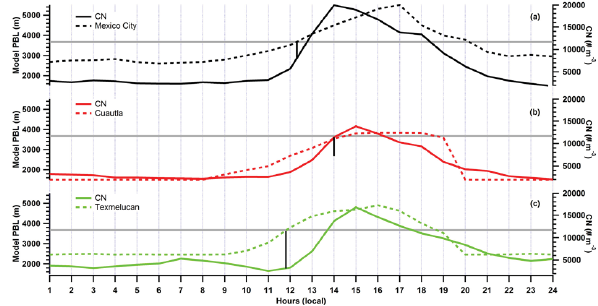
Figure 2. Hourly averages of the simulated boundary layer depths (a.s.l.) and observed CN concentrations are shown here for time periods when air originates from (a) the Fig. 2. Hourly averages of the simulated boundary layer depth WNW, (b) SW and (c) E. The grey line is a reference for the Altzomoni altitude in the model and the vertical black lines in each panel show the times when the (a.s.l.), drawn as dashed lines and observed CN concentration (solid simulated regional boundary layer reaches the altitude of Altzomoni. lines) are shown here for time periods when air originates from (a) the west northwest (Mexico City), (b) southwest (Cuautla) and (c) east (Texmelucan). The grey line is a reference for the Altzomoni research site altitude and the vertical black lines show the time when the simulated RML reaches the Altzomoni measurement